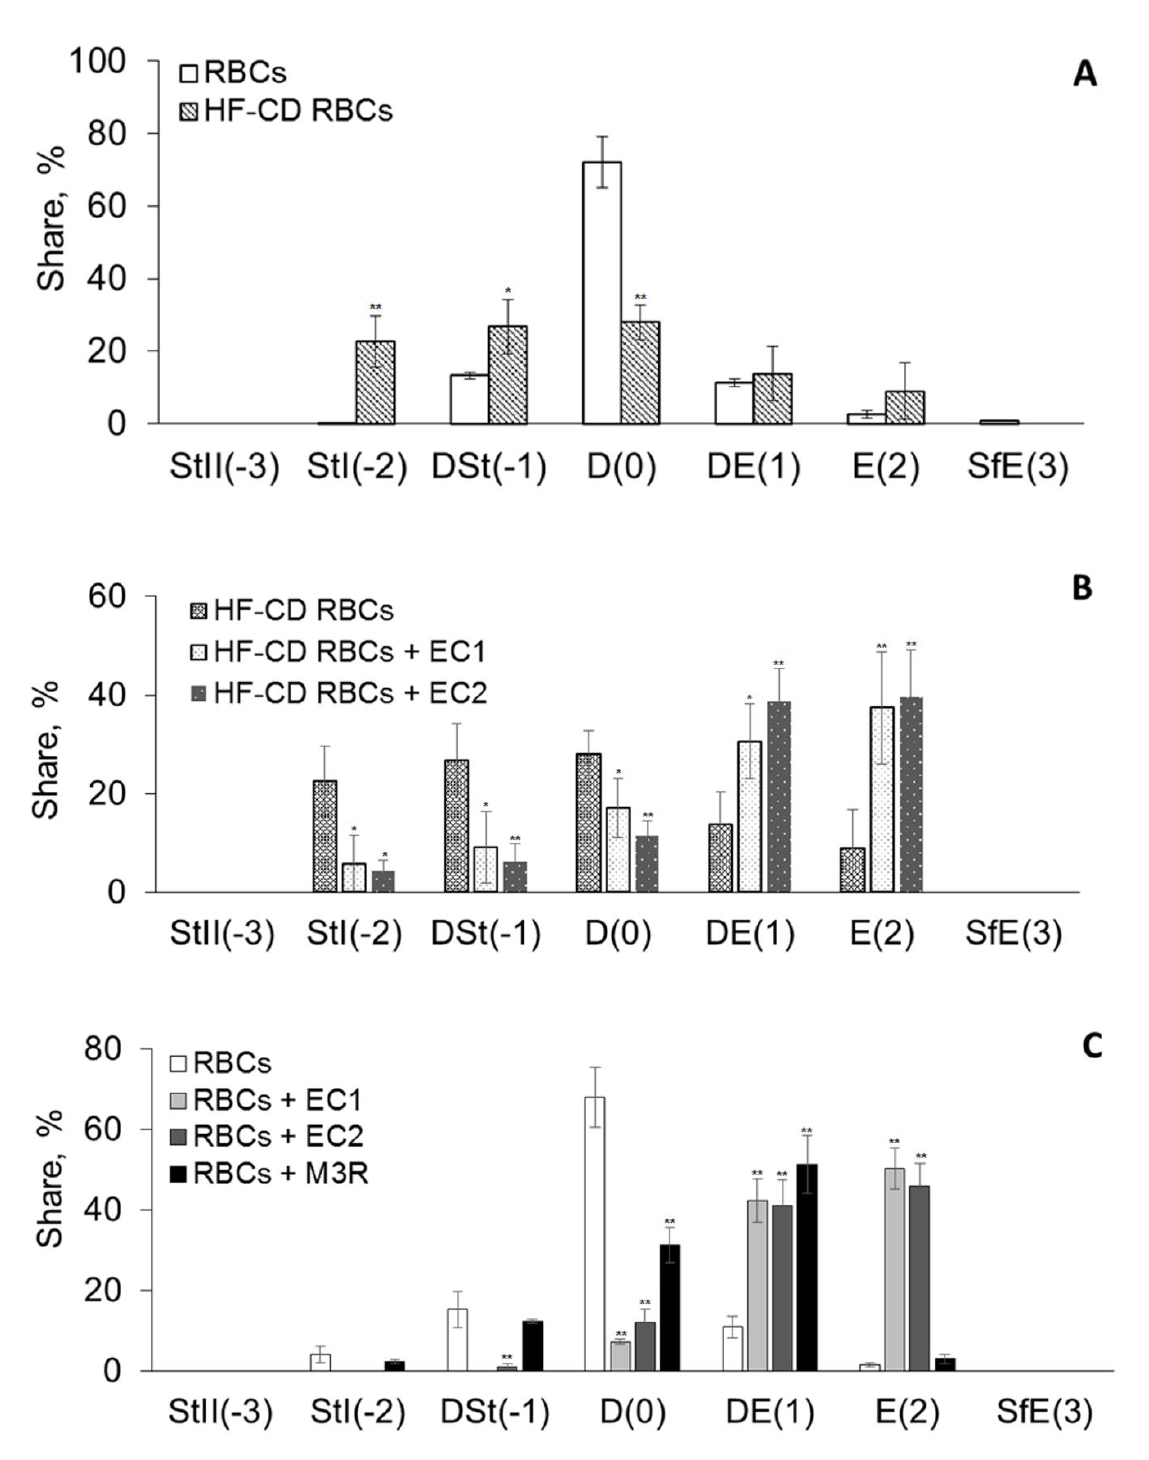
Figure 4. Percentage share of erythrocytes shapes obtained from control (RBCs) (Panel A ) * and pigs fed high fat-carbohydrates diet (HF-CD RBCs) (Panel B ) ** and these modified by EC1, EC2 and M3R used at 0.05 mg/mL (Panel C )